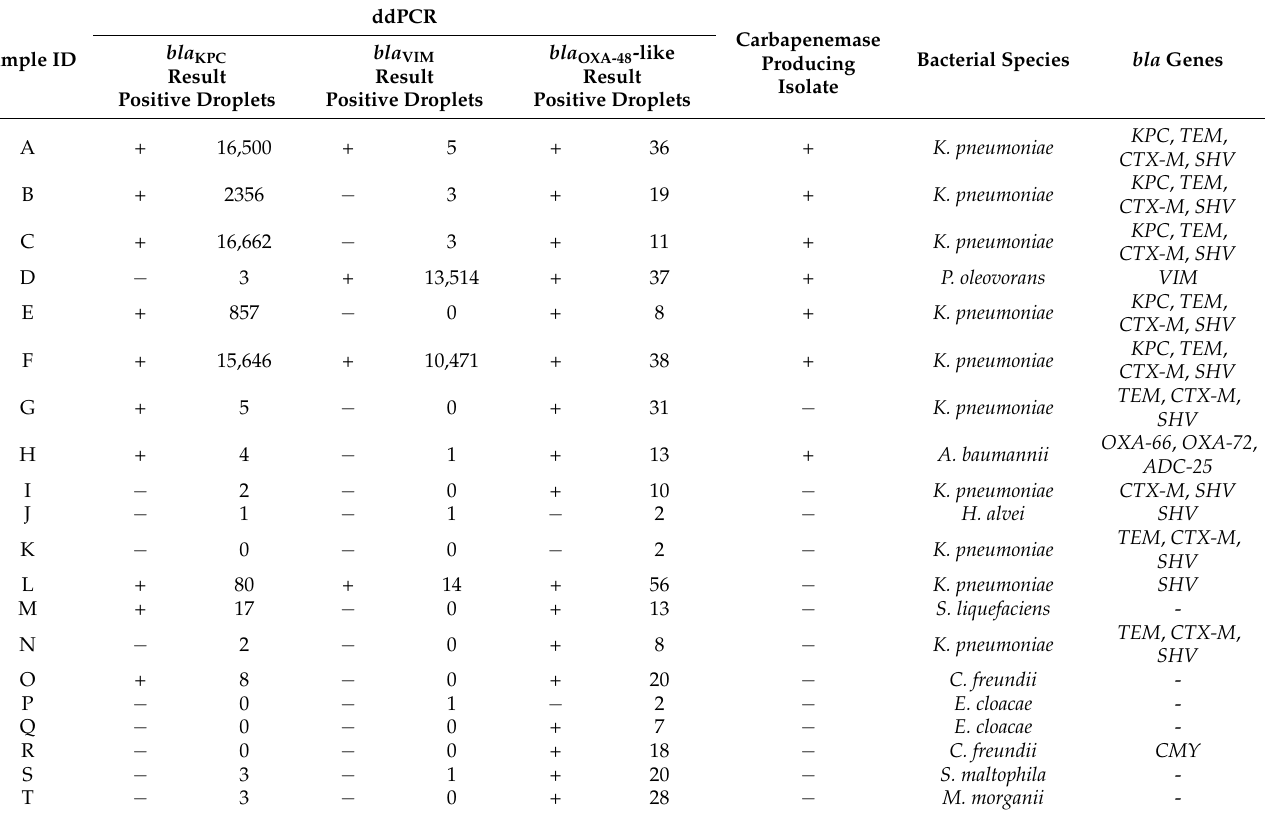
Table 3. Carbapenemase-positive samples of human feces as determined by culture method (Mac- Conkey Agar containing ertapenem), by ddPCR and by WGS